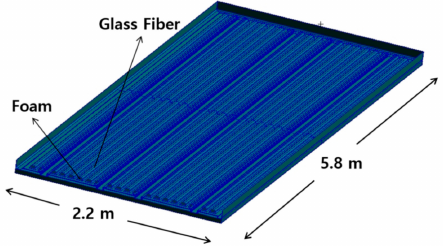
Figure 1. The designed floor structure for